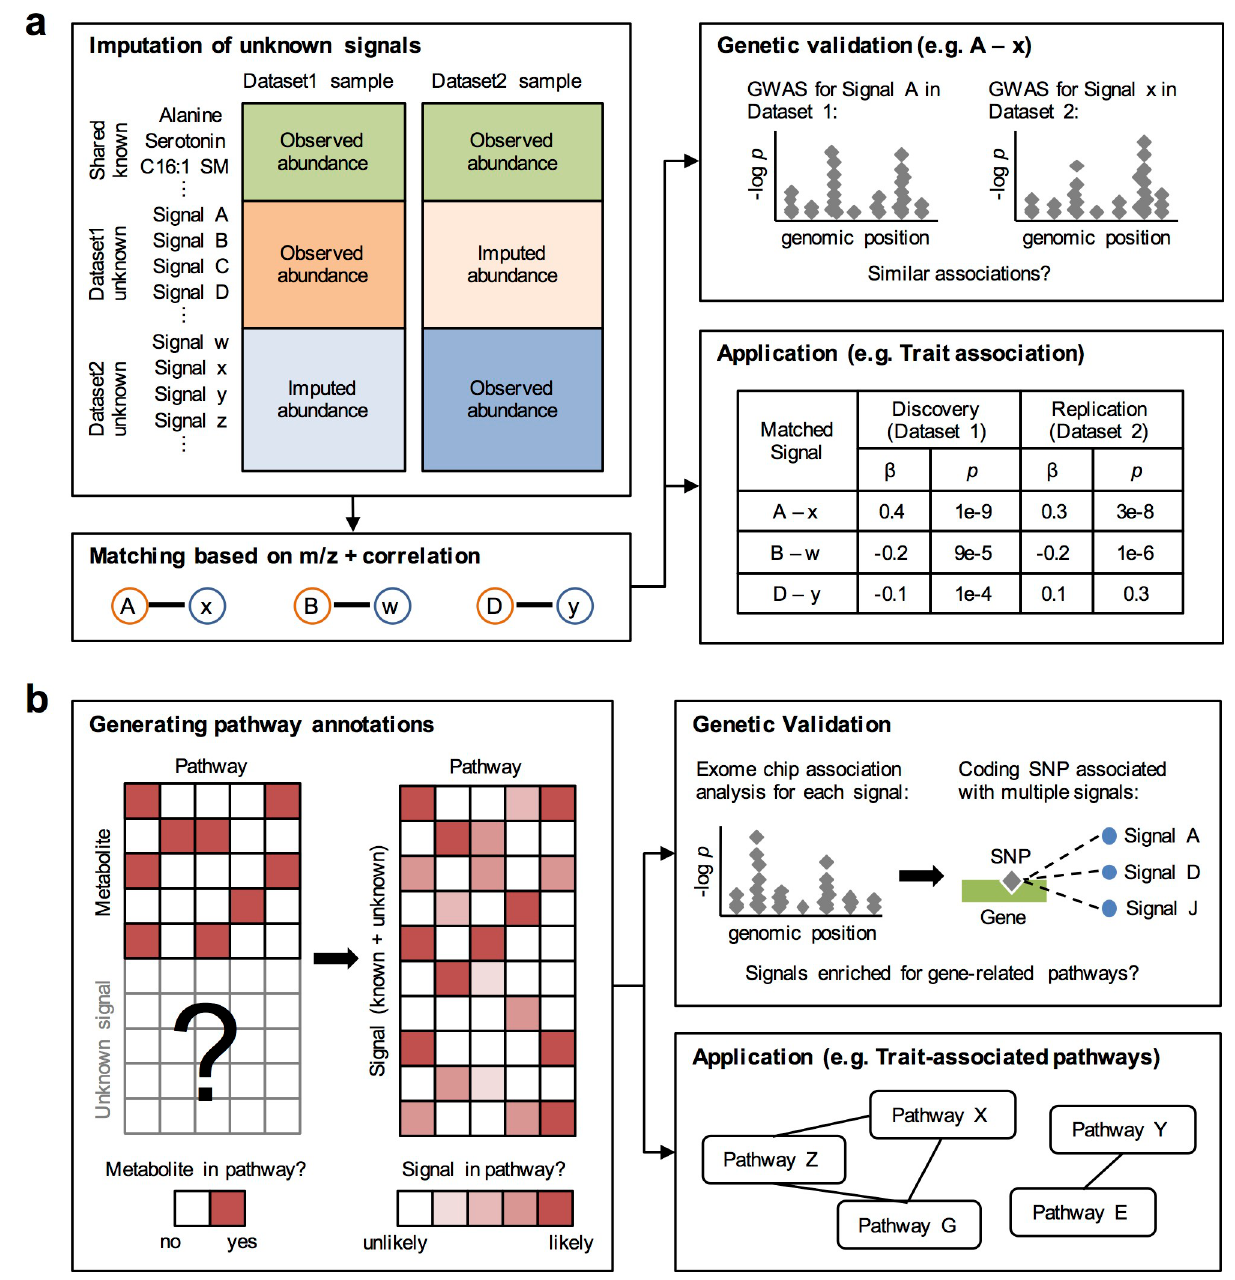
Fig 1. PAIRUP-MS is a suite of computational methods for analyzing metabolite signals in untargeted metabolomics data. (a) Overview of matching method: unknown (or unshared known) signals are imputed across datasets using shared known metabolites as predictors and then paired up based on m/z and correlation across samples. Genetic data can be used to validate matched signal pairs that share similar genetic associations. Matched signals can be used to perform combined association analyses across datasets (e.g. identifying trait-associated signals in discovery and replication cohorts). (b) Overview of pathway method: using binary metabolic pathway annotations and untargeted profiling data as input, a pathway reconstitution procedure is performed to construct a numeric annotation matrix, where each signal (known or unknown) gets a membership score in each pathway (or “metabolite set”, see Methods). Genetic data can be used to validate that signals associated with a specific gene are enriched for reconstituted pathways related to the gene. The annotation matrix can be used to perform pathway analyses (e.g. identifying pathways enriched for a list of trait-associated